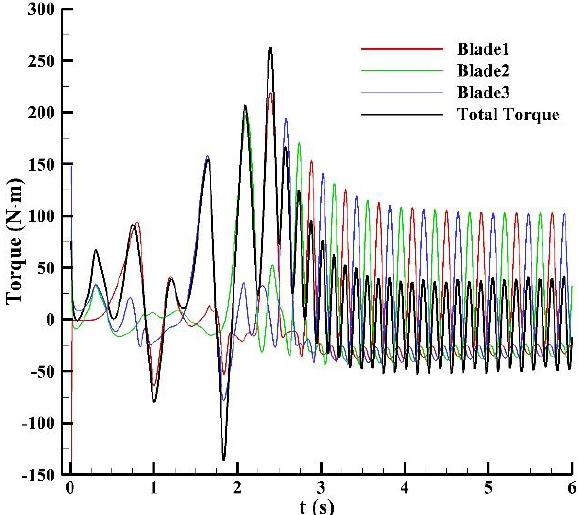
Figure 4. Time history of the instantaneous torques during the starting process.